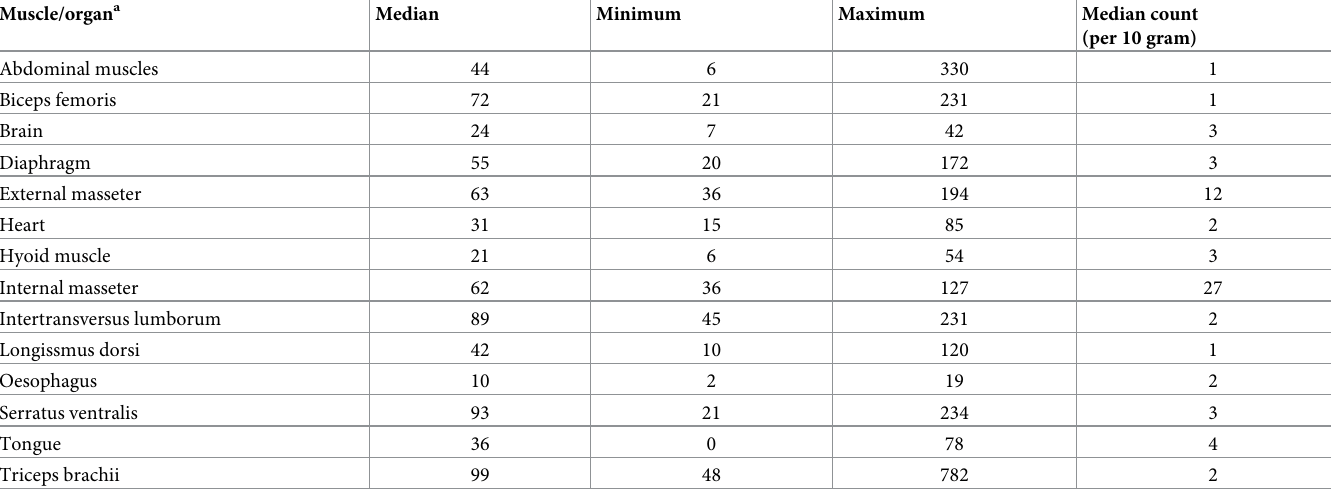
Table 3. Number of T . solium cysts recorded in different muscles and organs in naturally infected pigs in Punjab, India. Muscle/organ a